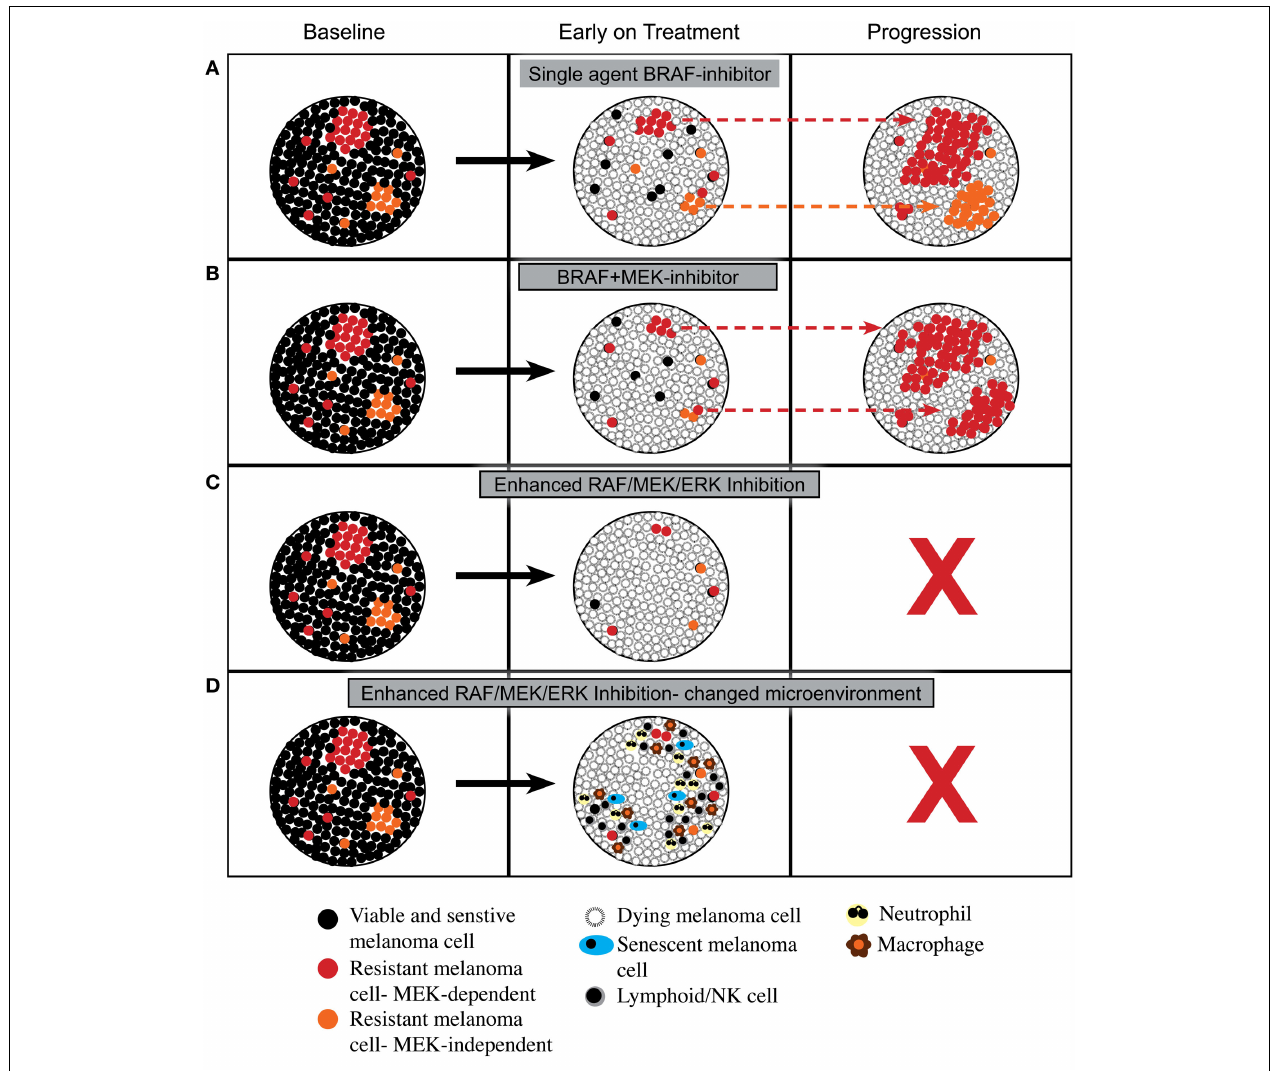
FIGURE 1 | Proposed cellular responses to inhibition of RAF/MEK/ERK signaling . (A) Response to single agent BRAF inhibitor with induction of cell death and then out growth of resistant cells having RAF/MEK/ERK-dependent mechanisms of resistance or RAF/MEK/ERK-independent mechanisms of resistance. (B) Response to combined BRAF and MEK inhibitors with induction of cell death and then out growth of resistant cells dominated